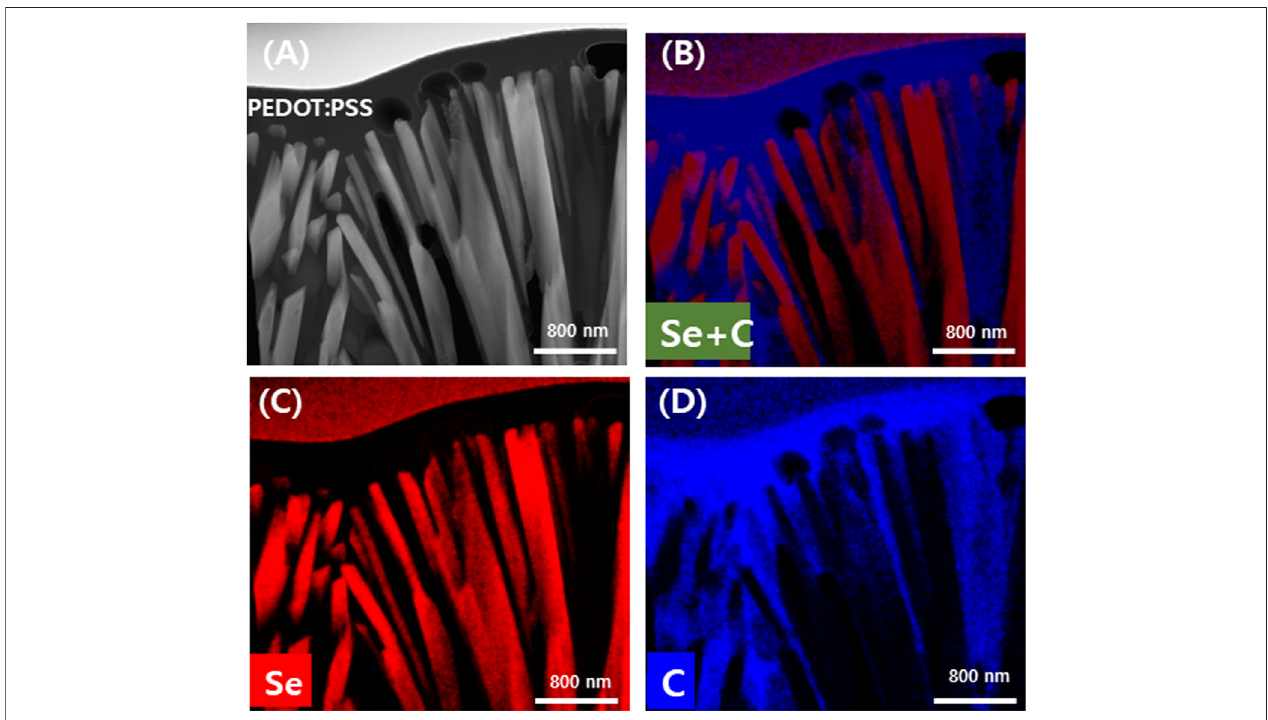
FIGURE 5 | Transmission electron microscopy energy dispersive spectroscopy analysis of the Se nanowires:PEDOT:PSS composite coated twice with PEDOT: PSS. TEM image (A) and mapping image according to element (B) Se and C (C) Se and (D) C.